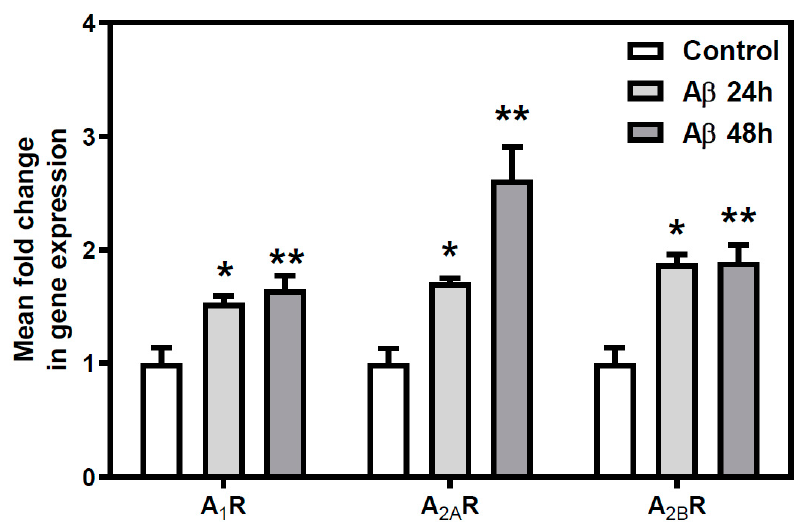
Figure 5. A β 25-35 effect on AR gene expression. Quantitative real-time PCR assays after A β 25-35 exposure were performed to measure the expression of A 1 R, A 2A R, and A 2B R genes. Histograms represent mean ± SEM values obtained from at least three independent experiments performed in duplicate using different preparations. * p < 0.05 ** p < 0.01 significantly different from control value using one-way ANOVA and Bonferroni’s post hoc test.